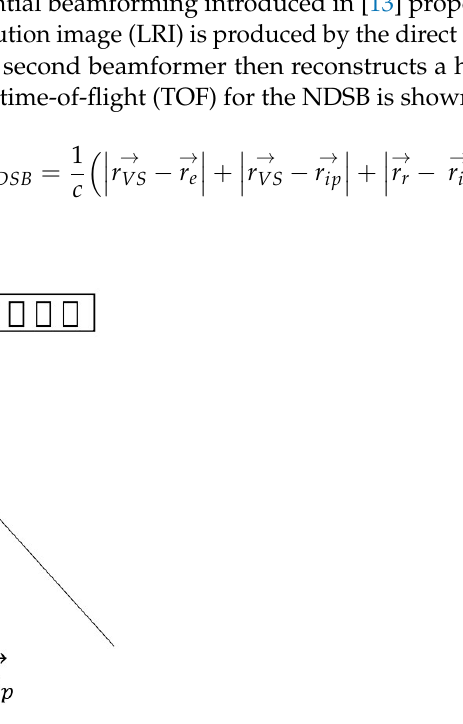
→ → → → r VS , r r , r e , and r ip denote the positions of the virtual